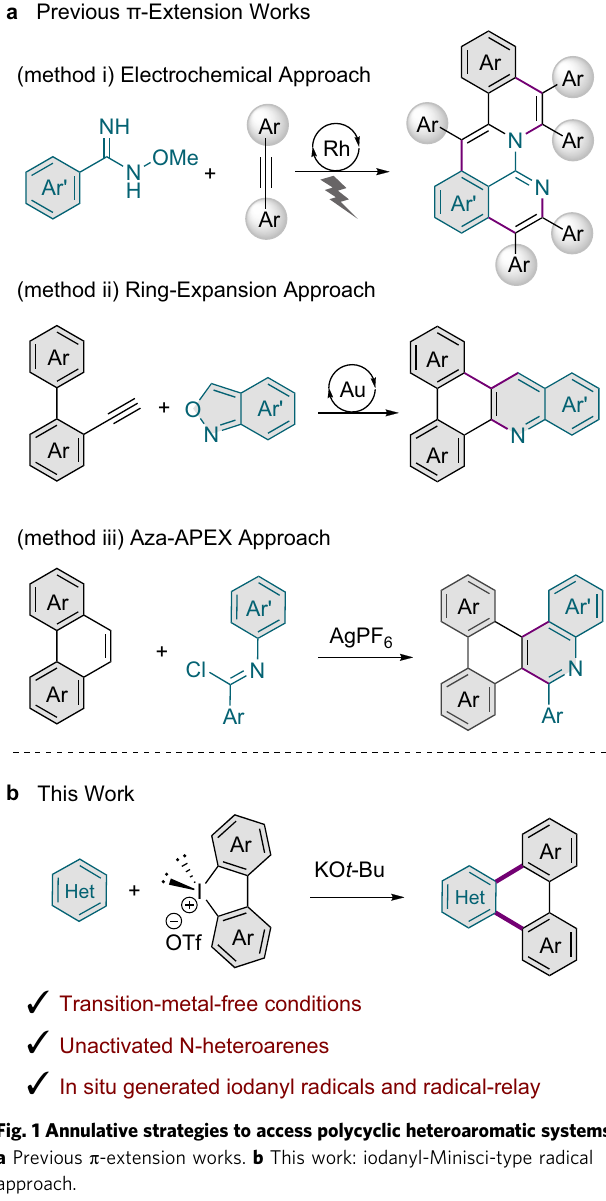
Fig. 1 Annulative strategies to access polycyclic heteroaromatic systems. a Previous π -extension works. b This work: iodanyl-Minisci-type radical